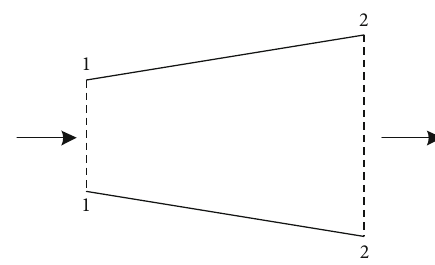
Figure 1: A system with only pressure loss.